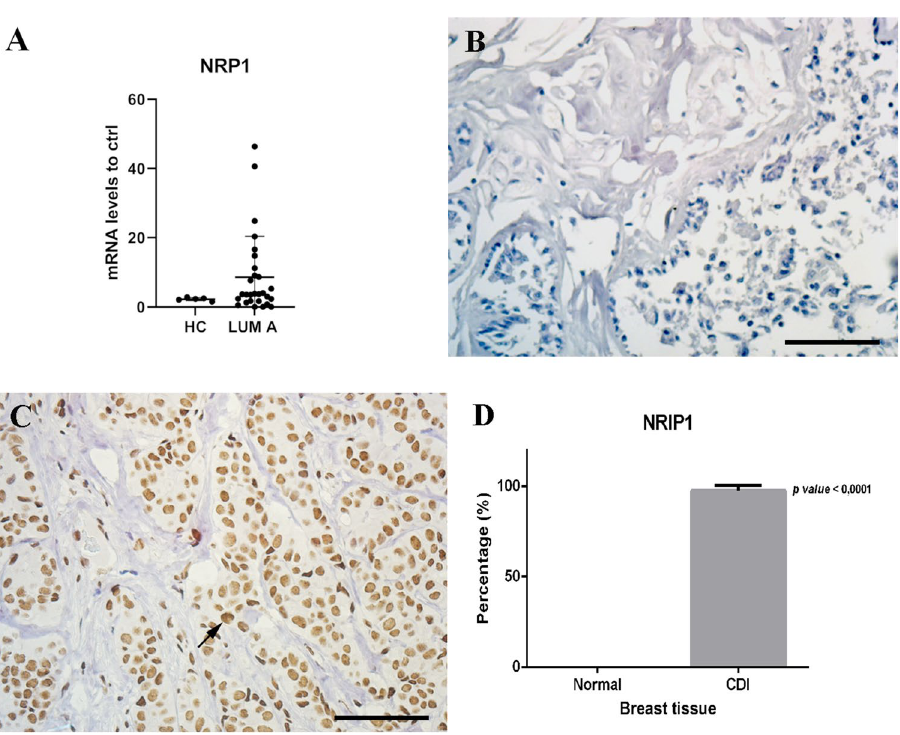
Figure 5. NRIP1 expression is increased in luminal A breast cancer patients. ( A ) To confirm NRIP1 expression, we used RT-qPCR to determine changes in NRIP1 mRNA expression levels in luminal A patients and healthy donors. ( B,C ) Immunohistochemistry assay showed that NRIP1 expression is increased in luminal A patients ( C ) compared to mammoplasty tissue ( B ). ( D ) Graphical representation of NRIP1. Statistical analyses showed increased NRIP1 expression in luminal A tissue compared to that in normal breast tissue (p-value < 0.0001). Scale bar: 100 µm; magnification: × 400. The arrow indicates positive